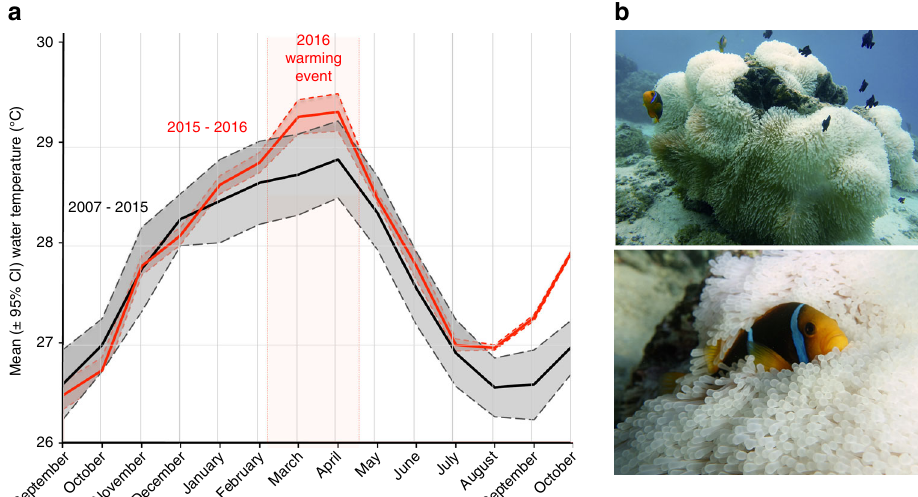
Fig. 1 Time series of mean water temperature data in Moorea lagoon, French Polynesia, before and during the study. a Monthly seawater temperatures over two periods: from 2007 to 2015 ( black ) and from September 2015 to August 2016 ( red ) 61 . Values are mean ± 95% con fi dence intervals. Vertical red lines and shading represents the 2016 warming anomaly event. b Adult anemone fi sh ( A. chrysopterus ) in bleached anemones ( H. magni fi ca